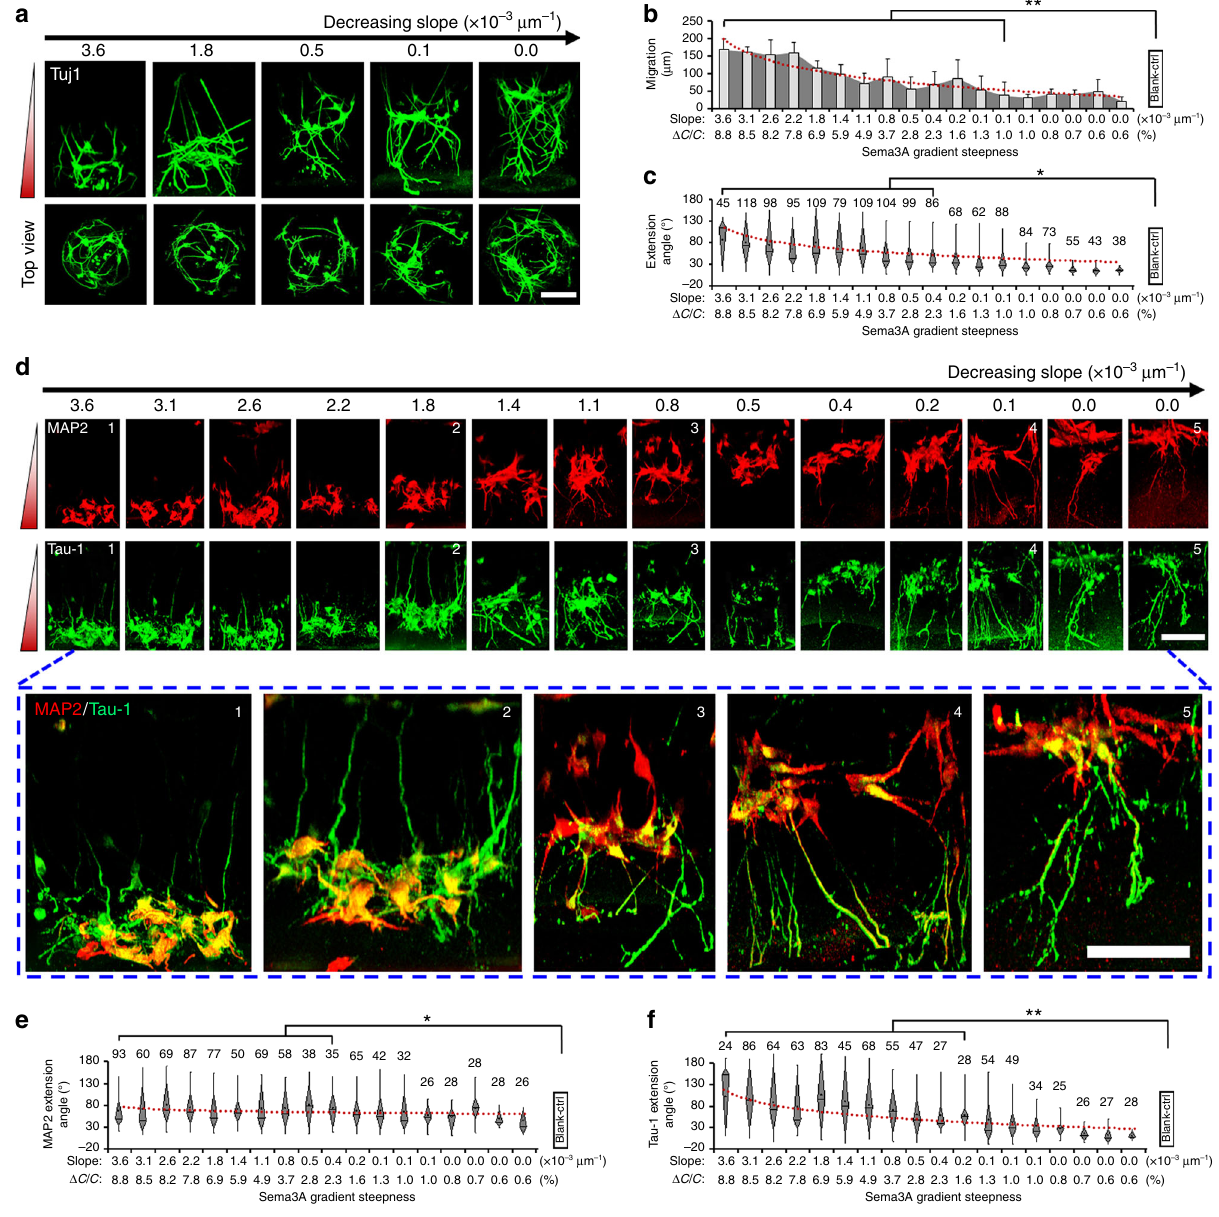
Fig. 4 Neuronal response to Sema3A gradients with varied steepness. a Side and top view of 3D cultured neurons ( β -tubulin) in response to Sema3A gradient of varied steepness, scale bar, 100 µ m. b Quantitative analysis of neuronal migration and related association with the Sema3A gradient steepness, n = 6, error bars indicate standard deviation. c Box-plots for quantitative analysis of neurite repellence in response to varied Sema3A gradient steepness. More than 40 neurites (as indicated on top of each box) were pooled from four biological replicates. d Representative views of axonal (Tau-1 + ) or dendritic (MAP2 + ) differentiation under Sema3A gradient of decreasing steepness. The combined images of the indexed subpanels were enlarged and shown in the boxed region. Scale bar, 100 µ m. e , f Box-plots for quantitative analysis of dendritic ( e ) or axonal ( f ) guidance in response to varied Sema3A gradient steepness. More than 20 neurites (as indicated on top of each box) were pooled from four biological replicates. For c , e , f , the parts of the box indicate 25, 50 and 75 percentiles, and the whiskers indicate 5% and 95%. The square mark indicates mean of the data. For b , c , e and f , the red line indicates a logarithmic fi tting of the data mean; neuronal growth pattern in each hydrogel cylinder was compared in pairwise to experiments without any chemotactic factor treatment (Blank-ctrl, Supplementary Fig. 6), * or ** indicates a p -value < 0.05 or <0.005 by paired Kruskal – Wallis